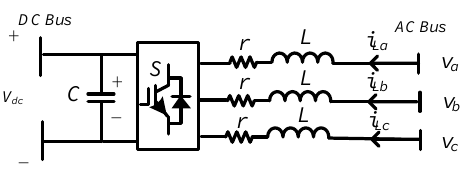
Figure 2. Topology of bidirectional power